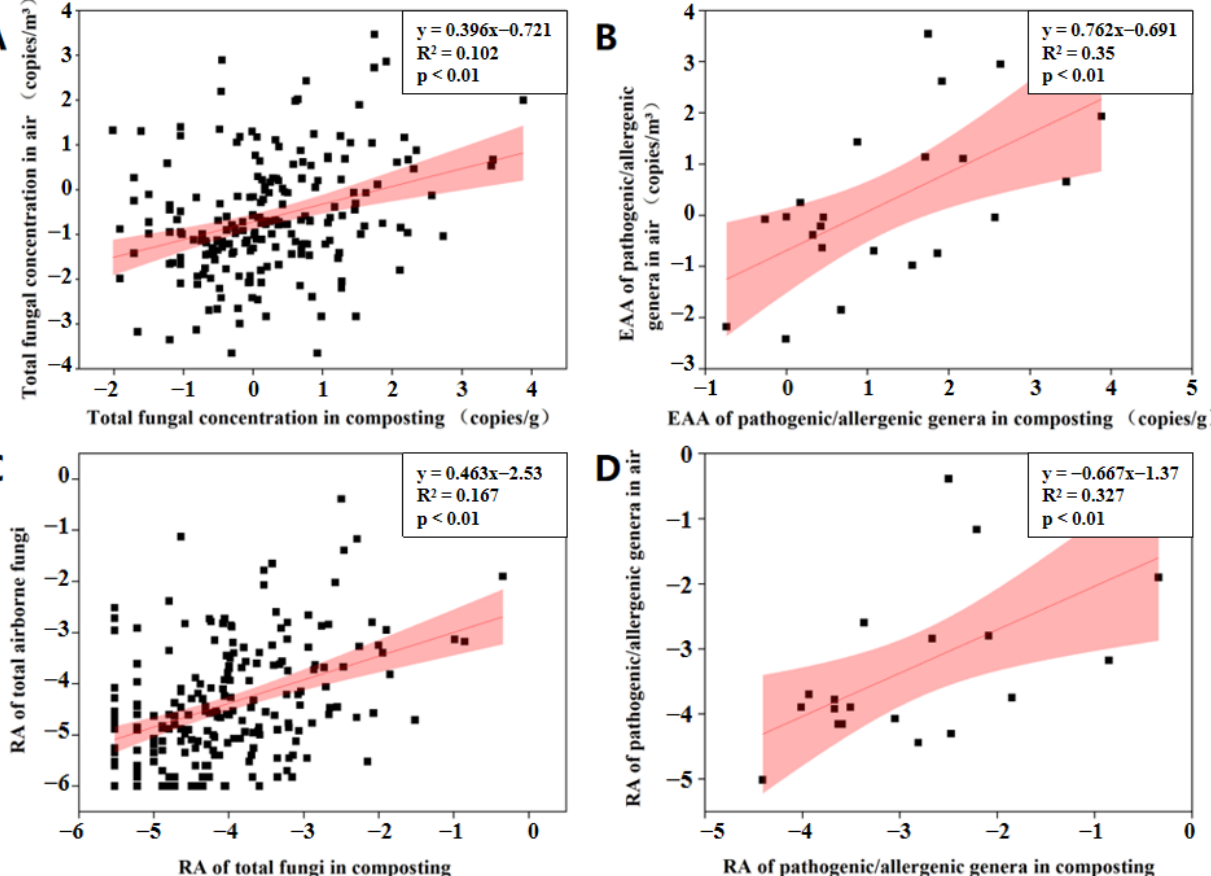
Figure 5. Correlation of fungal concentrations and relative abundances between air and compost piles using linear regression analysis. ( A ), total fungal concentrations; ( B ), the estimation of absolute abundance (EAA) of pathogenic/allergenic genera; ( C ), Relative abundance of total fungi; ( D ), Relative abundance of pathogenic/allergenic genera. Data were log-transformed.